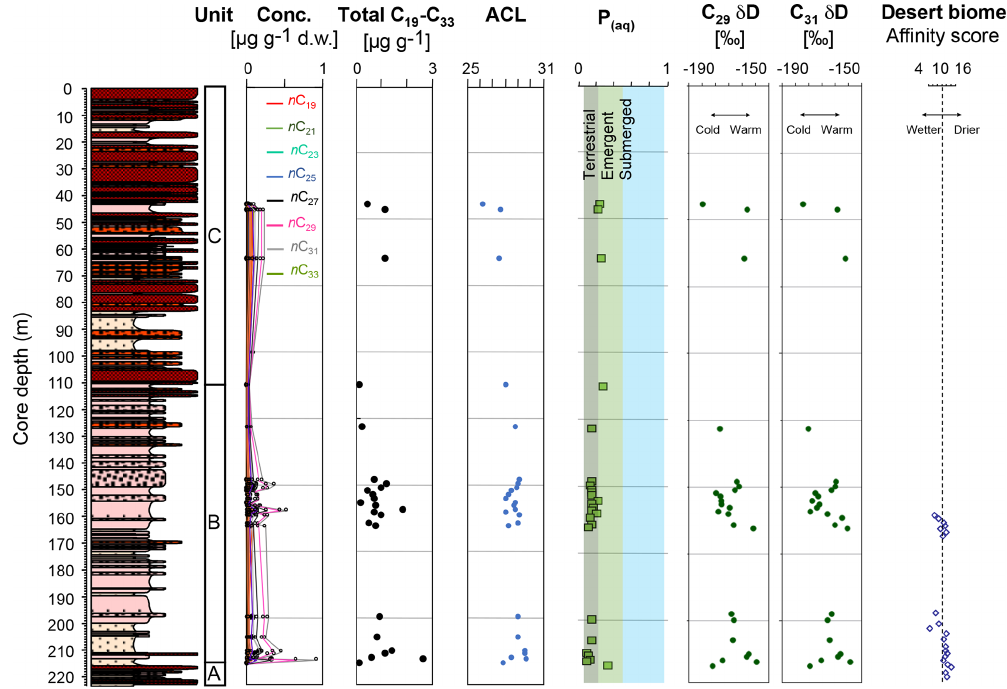
Figure 9. GN200 core with concentrations of n -alkanes (d.w. = dry weight) and average chain length (ACL); coloured areas highlight the interpretation of lipid origin (based on Ficken et al., 2000) and δ D values with palaeoclimate interpretations versus depth. The desert biome record from Fig. 8 is repeated for